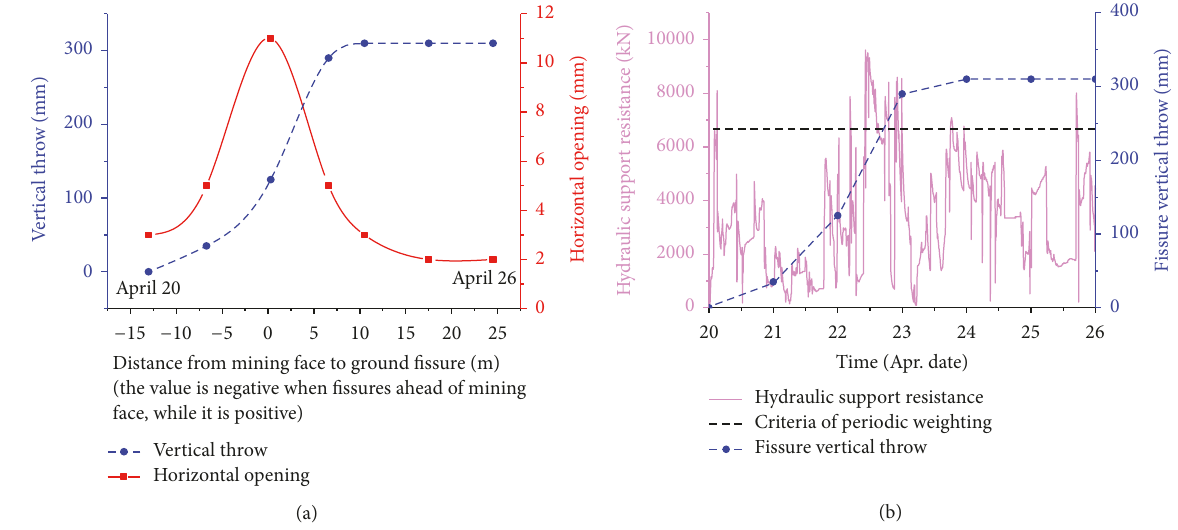
Figure 4: Borehole columnar section and major surface fissures of Working face 4104.